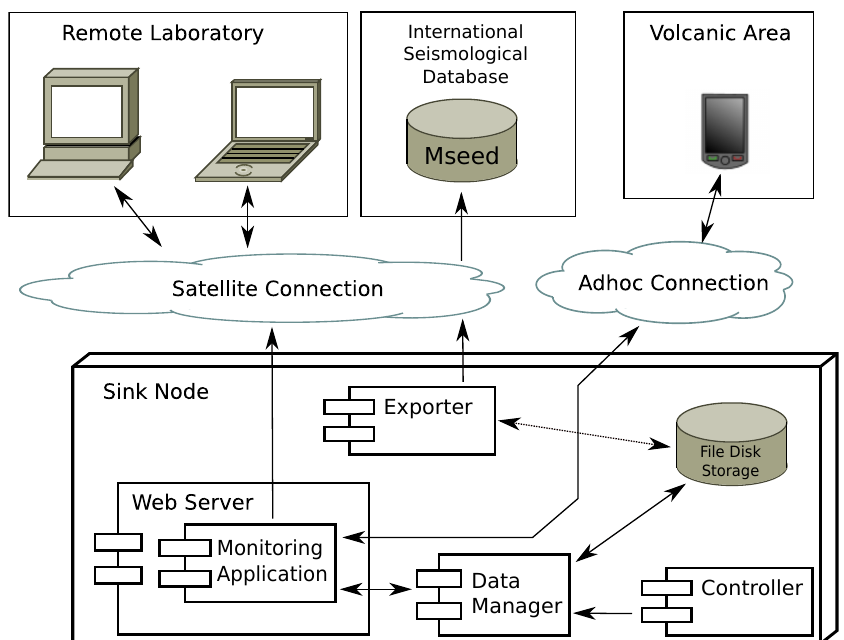
Table 1: Technical specification — case